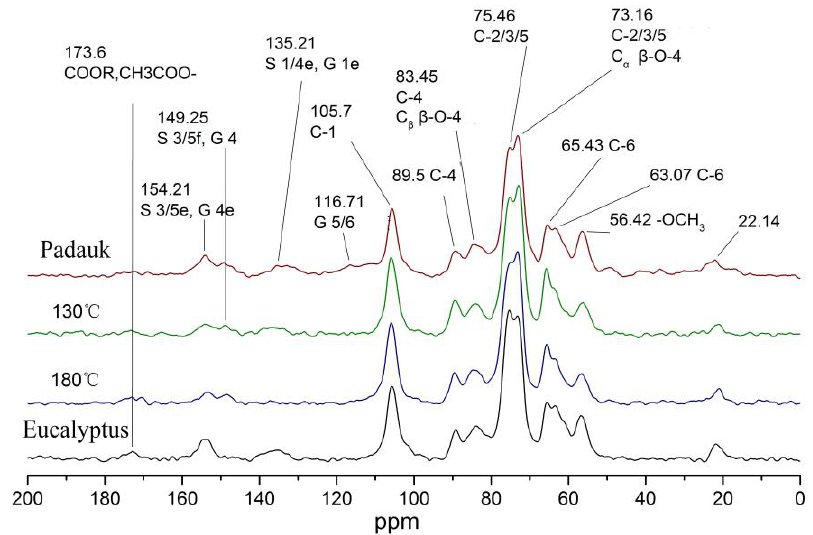
Figure 5. CPMAS- 13 C-NMR spectra of Eucalyptus and Burma padauk wood.